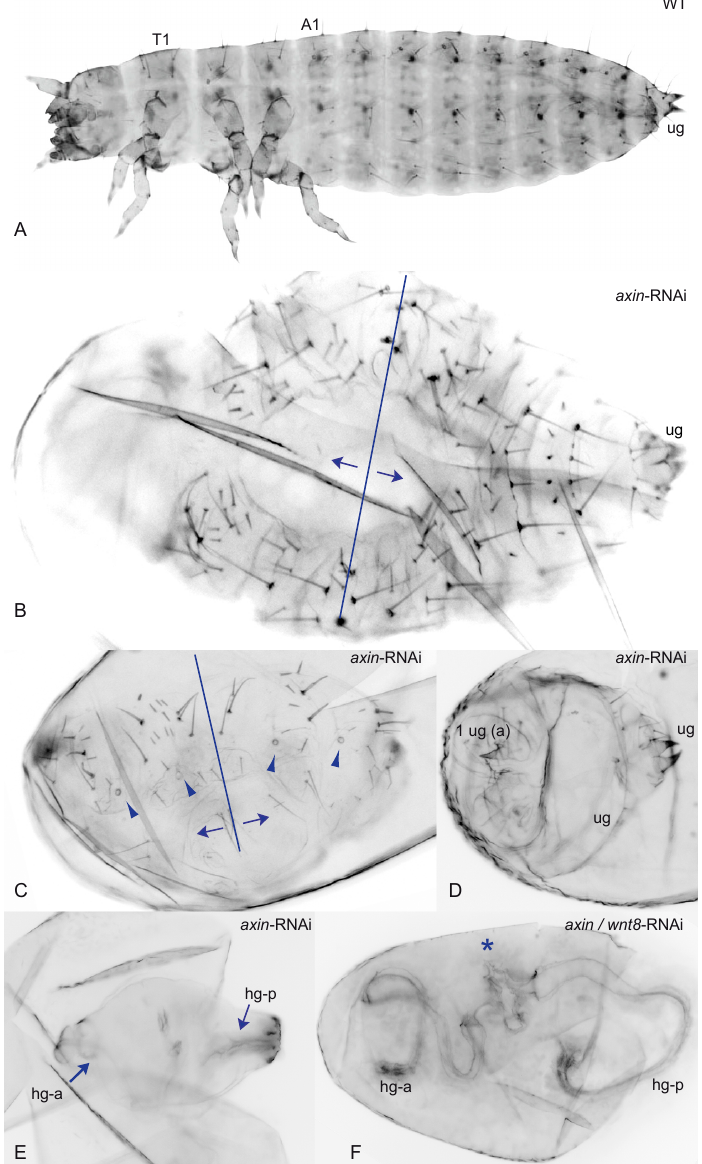
Figure 2. Polarity reversal in Tc-axin RNAi and Tc-axin / wnt8 RNAi cuticles. ( A ) Wild-type cuticle (ug: urogomphi) ( B – E ) Tc-axin RNAi polarity reversal phenotype. ( B , C ) Arrows indicate the polarity of the